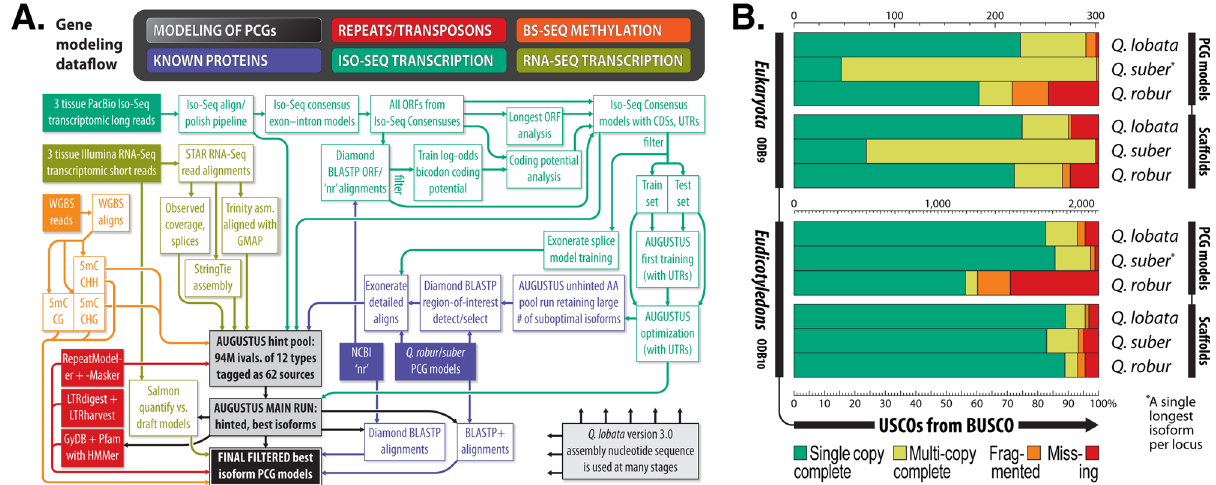
Fig. 7 Gene modeling. A Data fl ow of protein-coding gene (PCG) modeling. B BUSCO v3 analysis of PCG models and genomic scaffolds for Q. lobata , Q. robur , and Q. suber against the ODB9 Eukaryota and ODB10 Eudicotyledons USCO